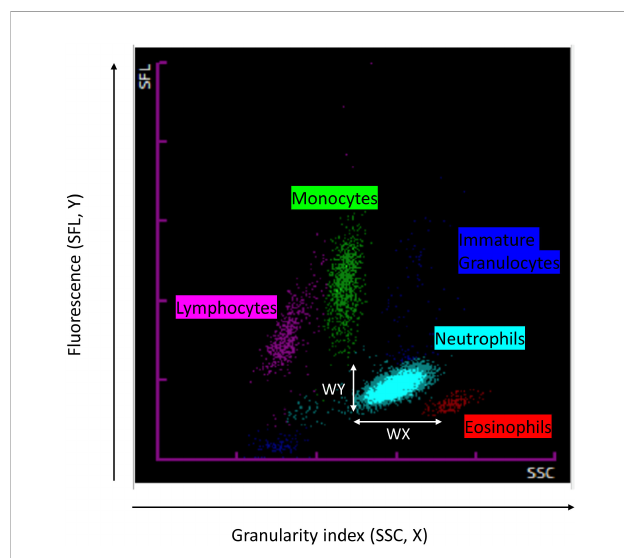
FIGURE 1 Cell population data parameters as visualized on the analyzer SCC: Granularity, SFL: